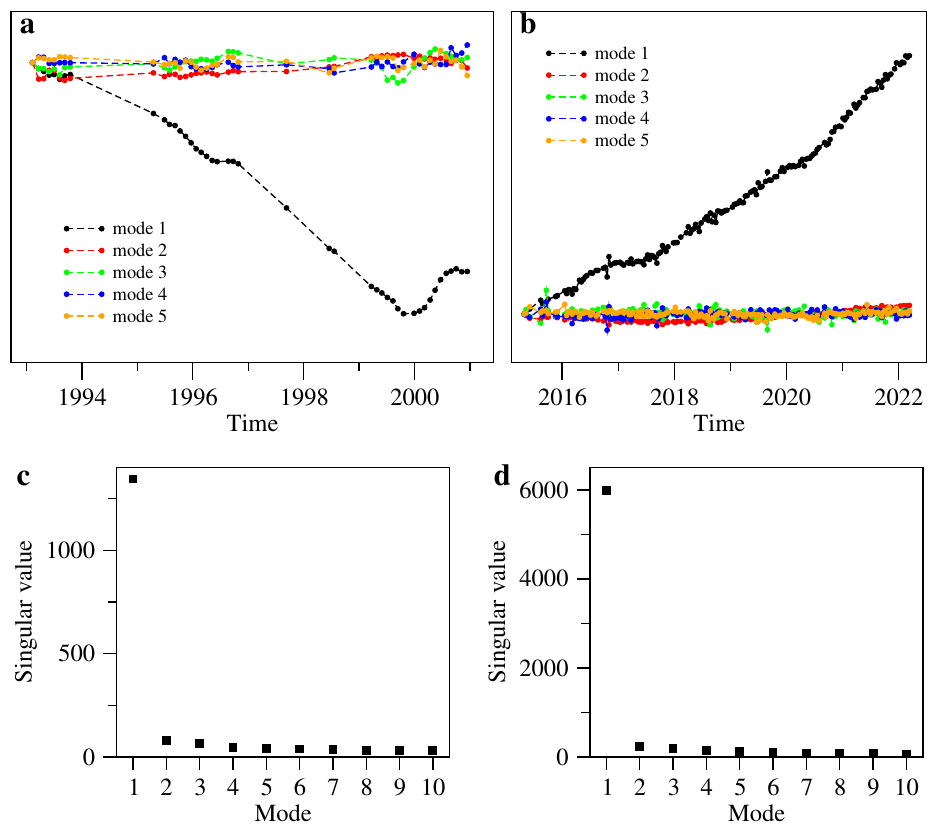
Figure 6. Temporal evolutions and singular values for the first modes from the joint EOF analysis of vertical and eastward displacements: ( a ) temporal evolutions from ERS/ENVISAT data; ( b ) temporal evolutions from Sentinel-1A data; ( c ) singular values from ERS/ENVISAT data; ( d ) singular values from Sentinel-1A data. The y-axis scales in ( a , b ) are arbitrary because the temporal evolution has to be multiplied by the related vertical and eastward displacement EOF coefficient of each pixel to obtain displacement time